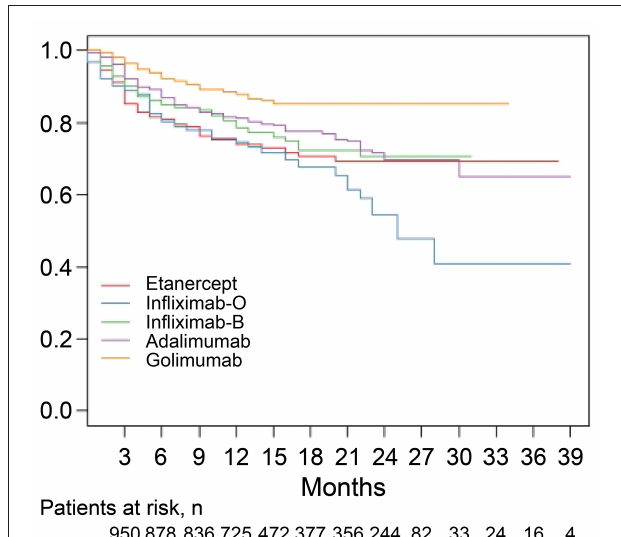
FIGURE 2 | Drug retention rates for individual tumor necrosis factor inhibitors (TNFi) in patients with ankylosing spondylitis (AS). An estimate of the drug failure showed that the adjusted hazard ratio (HR) for golimumab compared to etanercept was 0.441 (95% CI: 0.277–0.703, p < 0.001). A Cox proportional hazard model with adjustment for covariates including age, sex, and disease duration was applied to compare the time to discontinuation of golimumab treatment with the time to discontinuation of other TNFis. O, originator; B,